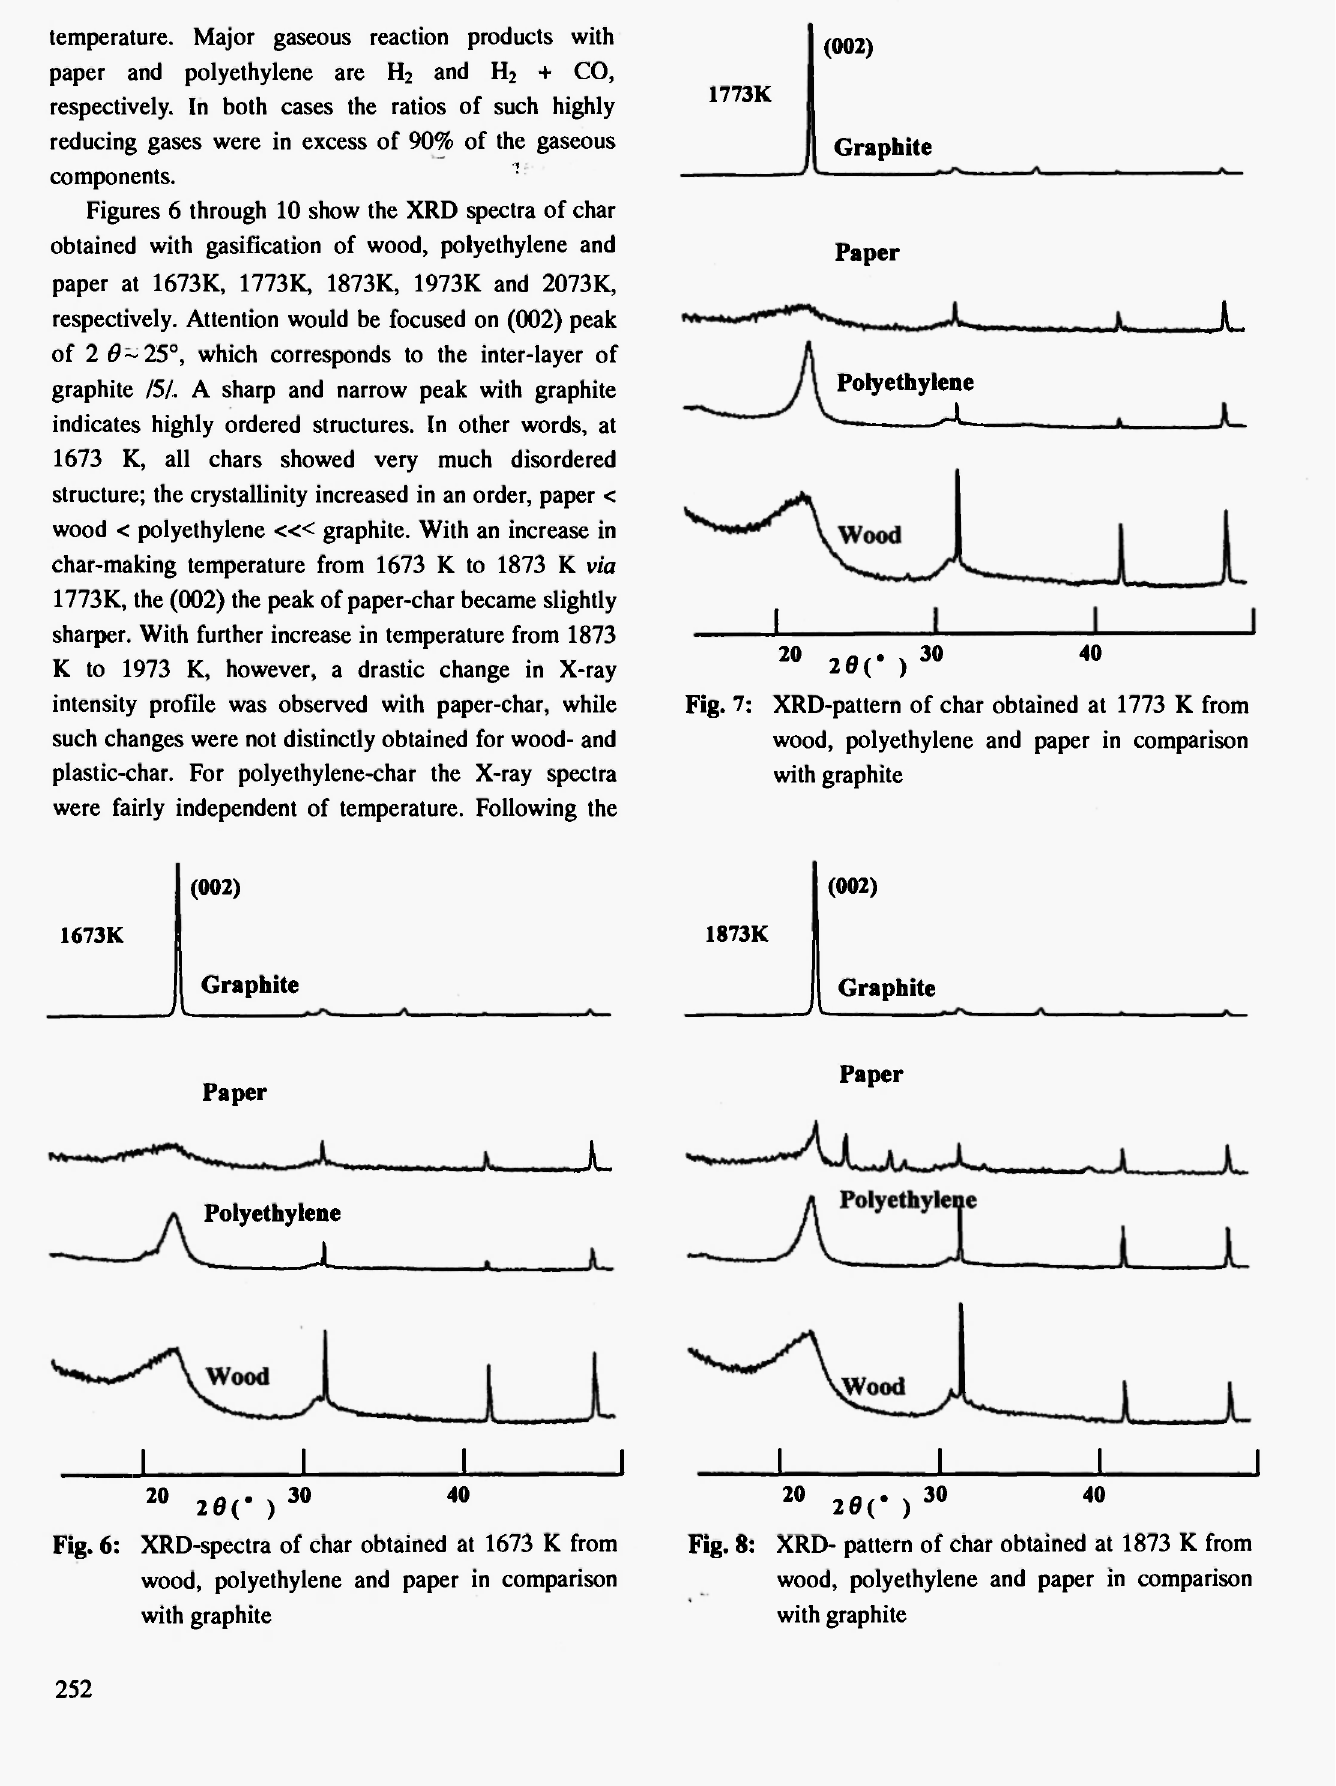
Fig. 6: XRD-spectra of char obtained at 1673 Κ from wood, polyethylene and paper in comparison with graphite